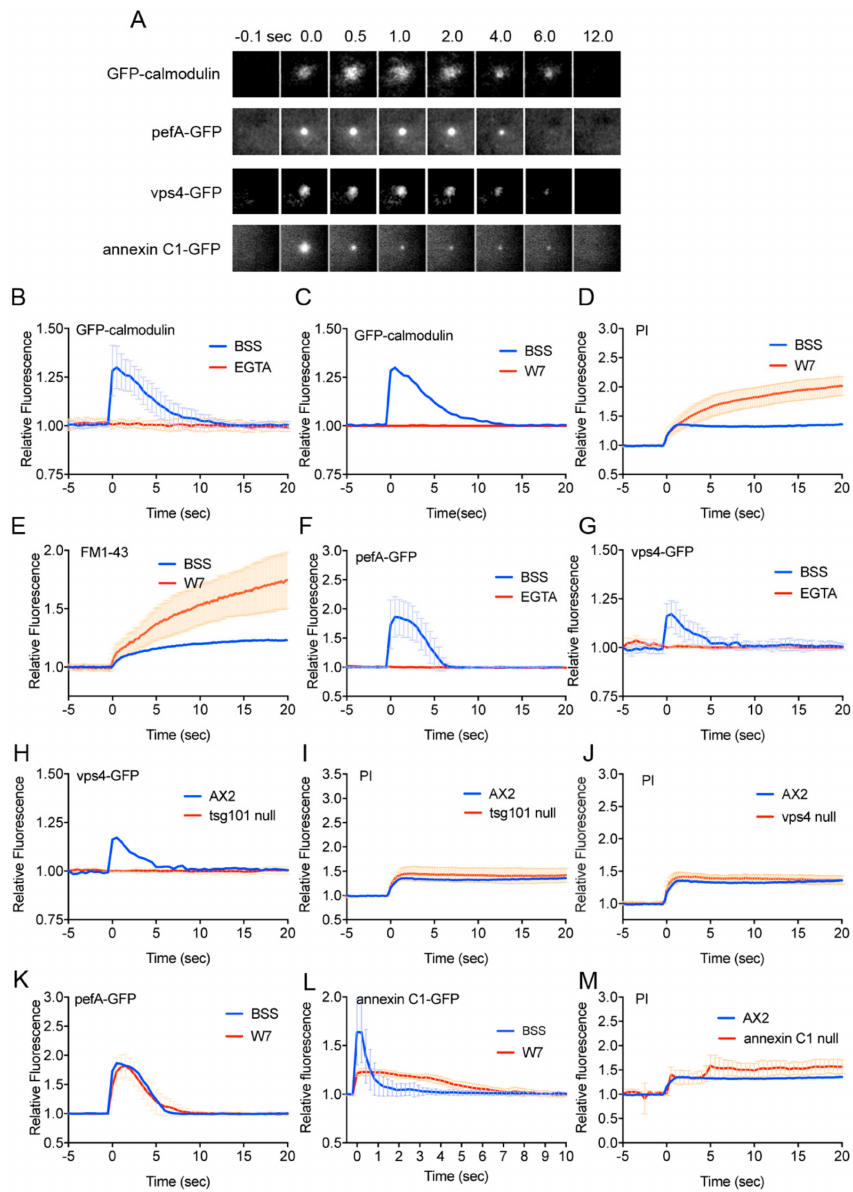
Figure 2. Calmodulin, ESCRT, and annexin quickly accumulate at the wound site. ( A ) Typical sequences of fluorescence images at the wound sites in cells expressing GFP-calmodulin, pefA-GFP, vsp4-GFP, and annexin C1-GFP. ( B ) The time course of fluorescence intensity of GFP-calmodulin at the wound site in the presence and absence of Ca 2 + . ( C ) The time course of GFP-calmodulin in the presence and absence of W7. ( D ) The time course of PI influx in the presence and absence of W7. ( E ) The time course of FM1-43 influx in the presence and absence of W7, an inhibitor of calmodulin. ( F ) The time course of fluorescence intensity of pefA-GFP in the presence and absence of Ca 2 + . ( G ) The time course of fluorescence intensity of vps4-GFP in the presence and absence of Ca 2 + . ( H ) The time course of fluorescence intensity of vps4-GFP in tsg101 null and wild type cells. ( I ) The time course of PI influx in tsg101 null and wild type cells. ( J ) The time course of PI influx in vps4 null and wild type cells. ( K ) The time course of fluorescence intensity of pefA-GFP in the presence and absence of W7. ( L ) The time course of fluorescence intensity of annexin C1-GFP in the presence and absence of W7. ( M ) The time course of PI influx in annexin C1 null and wild type cells. All graphs are shown with average ± SD (n = 25,